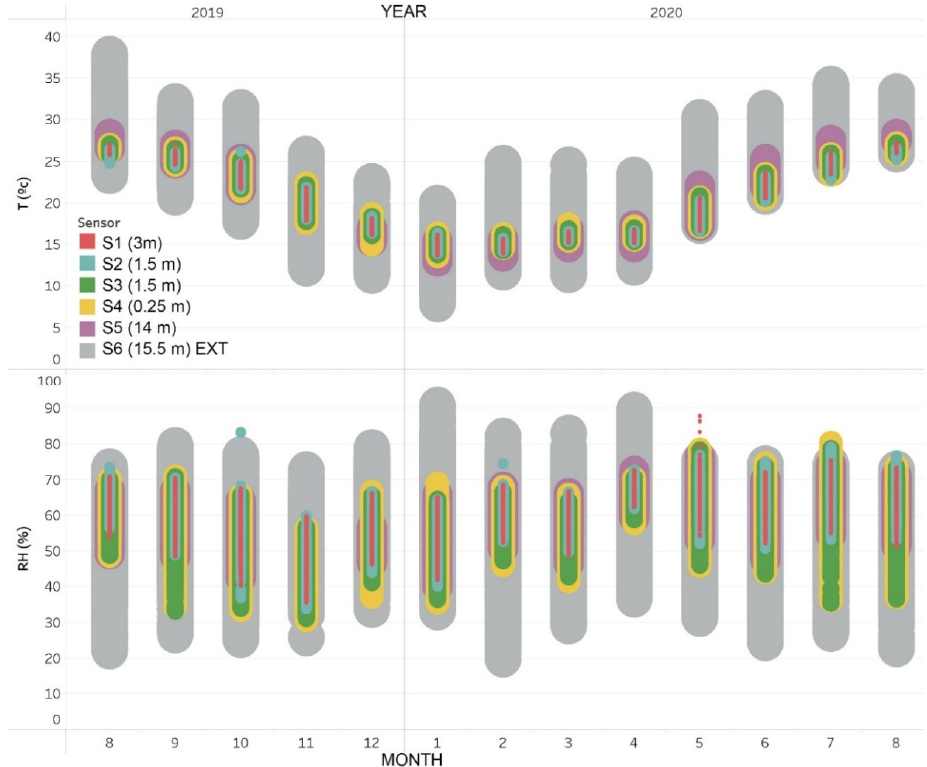
Figure 5. Overview of Temperature and Relative Humidity for each month.